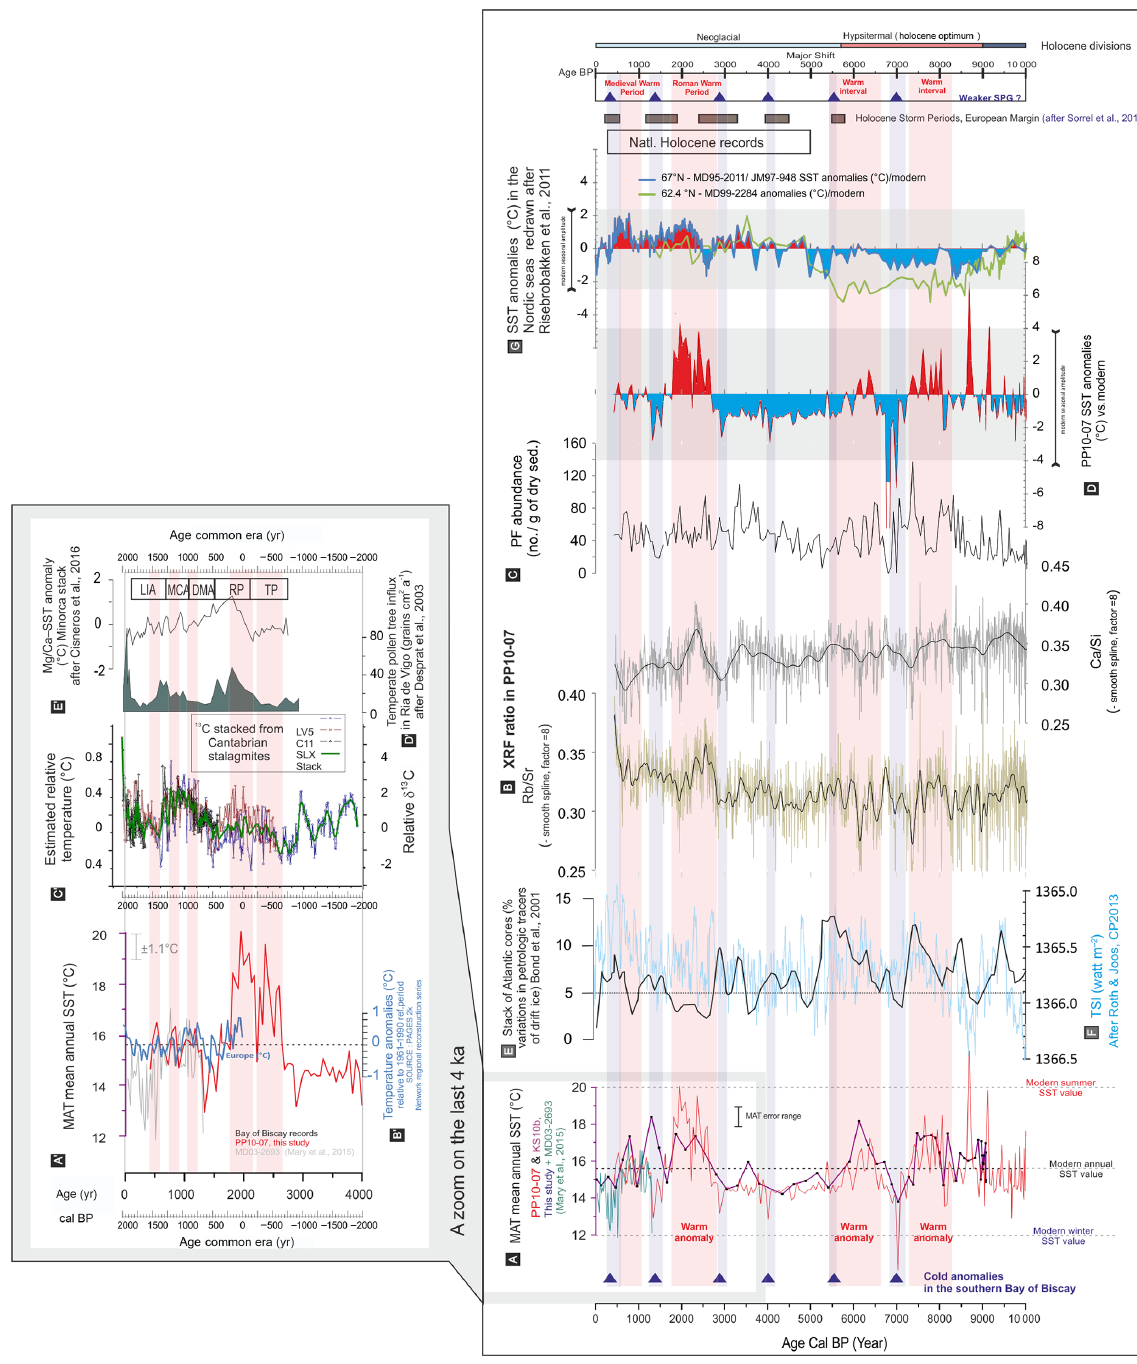
Figure 5. Gathering data and forcing: comparison of the Bay of Biscay (BB) signals ( a annual SST, b XRF ratio in PP10-07, c planktonic foraminifera absolute abundances in PP10-07, d annual SST anomalies vs. modern mean in PP10-07), with key Holocene records, i.e. (e) Bond et al. (2001) record; (f) total solar irradiance reconstruction after Roth and Joos (2013); (g) annual SST anomalies in the Nordic seas (eastern) digitized from Risebrobakken et al. (2011, Fig. 3). The dark blue triangles and light blue vertical bands point to cold anomalies recorded in the BB (potentially corresponding to a weak SPG). On the left are compiled data from the last 4kyr with (a (cid:48) ) BB annual SST; (b (cid:48) ) reconstruction of the European temperature anomalies (from 30-year averages) of the PAGES 2k Network (2013); (c (cid:48) ) Cantabrian speleothem δ 13 C stack reflecting 4kyr land surface temperature changes, digitized after Martín-Chivelet et al. (2011); (d (cid:48) ) temperate pollen tree influx from the proximal Ria de Vigo, redrawn after Desprat et al. (2003), (e (cid:48) ) Mg / Ca SSt anomaly in Minorca and related historical events after Cisneros et al. (2016) (Talaiotic Period – TP; Roman Period – RP; “Dark Middle Ages” – DMA; Medieval Climate Anomaly – MCA; Little Ice Age –